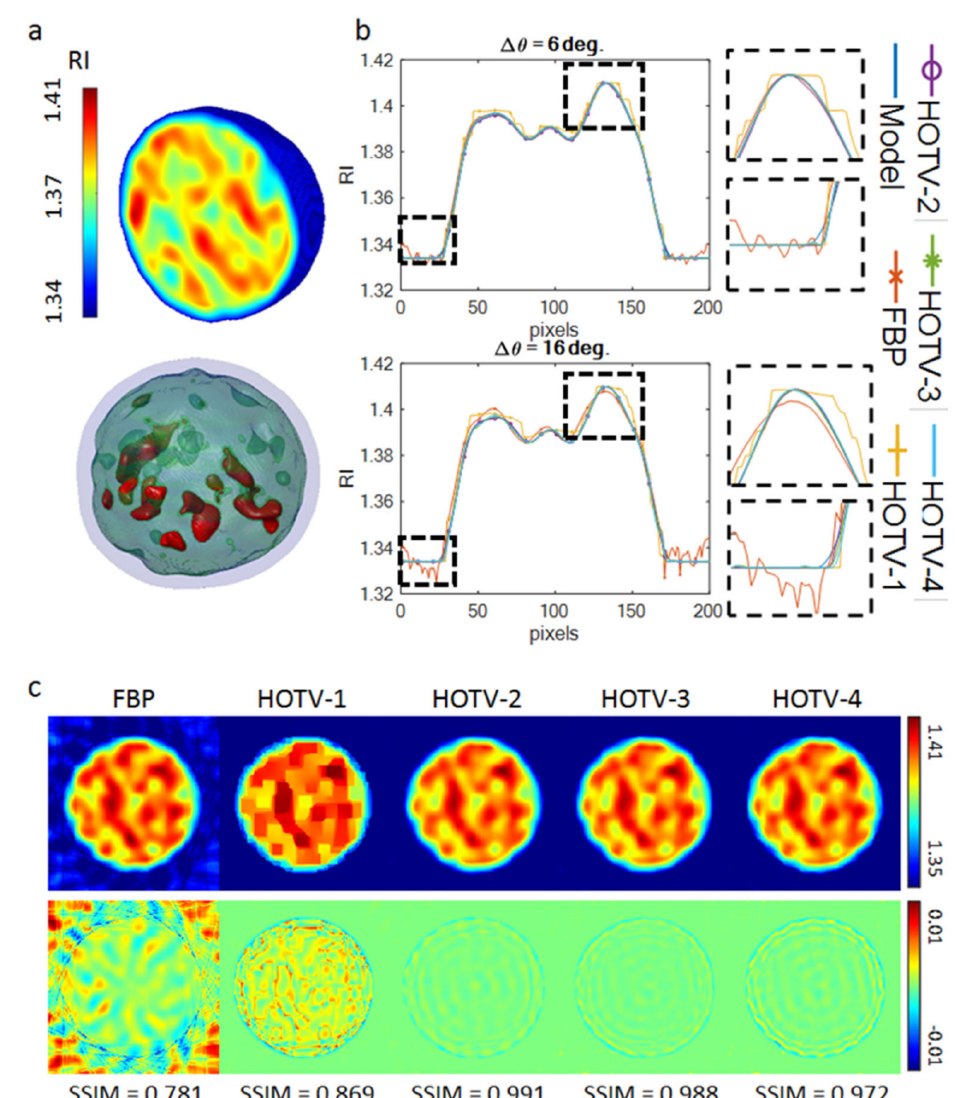
Figure 3. Monocyte simulation. ( a ) 3D ( top ) and isolevel ( bottom ) visualization of the simulated monocite, ( b ) horizontal cut through the central slice of the reconstructed tomograms for ∆ θ = 6 ◦ and ∆ θ = 16 ◦ , considering different solvers, ( c ) top row: central slice of the reconstructed tomograms considering different solvers for ∆ θ = 16 ◦ , bottom row: difference slice between the reconstructions obtained with different solvers and the simulated model. Length of the reference scale bar is 5 µ